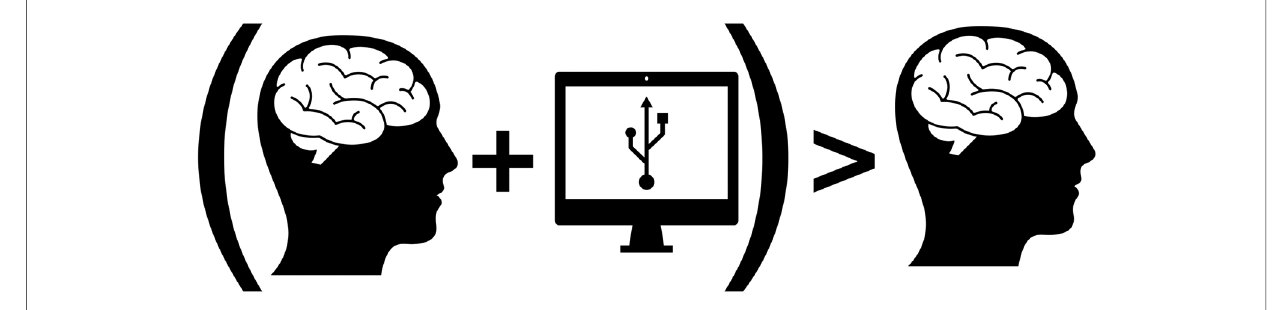
FIGURE 1 Modi fi ed picture originally published by Friedman